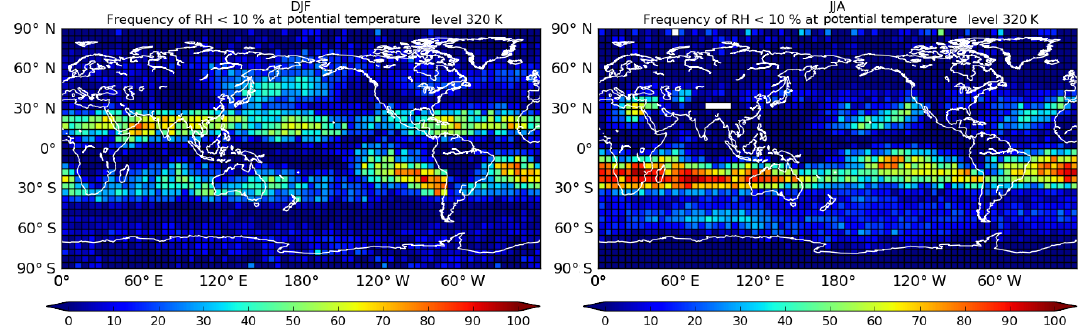
Figure 8. Frequency for RH < 10% at the potential temperature level 320K for DJF and JJA